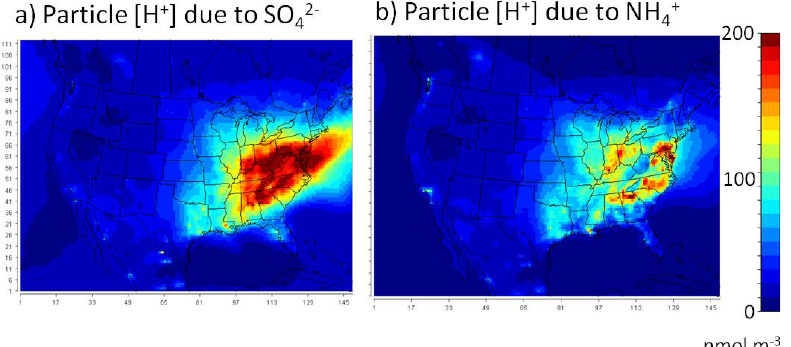
Fig. 6. Particle-phase H + concentration due to sulfate (a) and the neutralizing concentration of ammonium (b) . Values are averaged for July 2003.